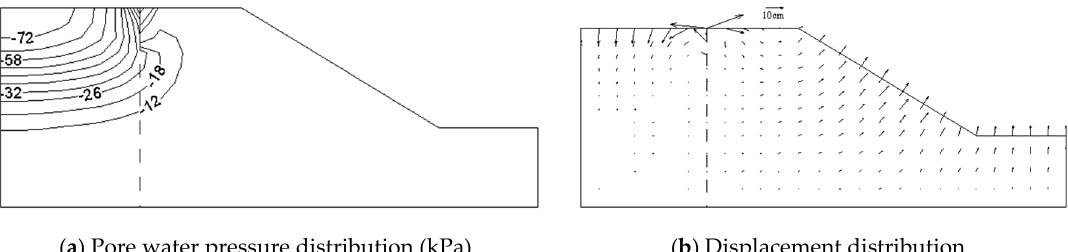
Figure 14. The distributions of pore water pressure and displacement at the end of rainfall with an